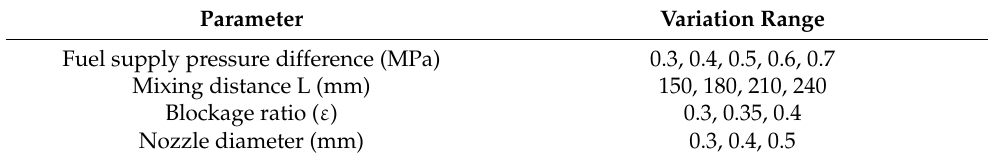
Table 3. The parameter variation